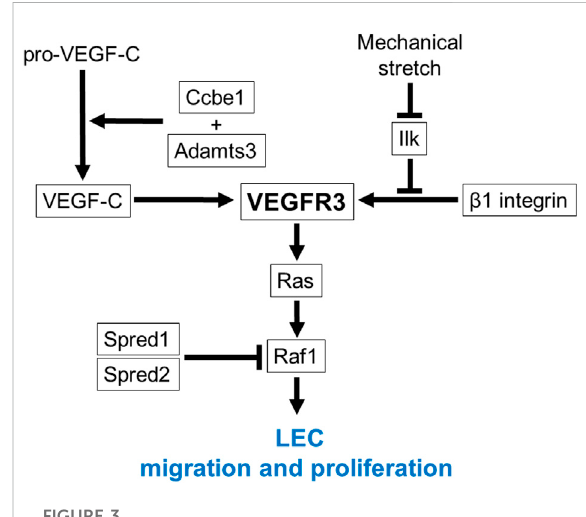
FIGURE 3 VEGFR3 signaling in migration and proliferation of LEC progenitors. VEGFR3 functions as a main signaling receptor for migration and proliferation of LEC progenitors. Ccbe1 and Adamts3 cleave pro-VEGF-C and produce active form that allows binding to VEGFR3. Binding of VEGF-C to VEGFR3 results in tyrosinephosphorylation,whichinturnactivatesRas/Rafsignaling. Raf activity is negatively regulated by Spred1 and Spred2. VEGFR3 signaling is also regulated by β 1 integrin in a VEGF-C independentmanner. β 1integrininteractiontoVEGFR3isinhibited byIlk,but uponmechanicalstretch, thecomplexof β 1integrinand Ilk is transiently disrupted, which in turn promotes VEGFR3 phosphorylation. Causative genes for fetal nuchal edema in mice are surrounded by